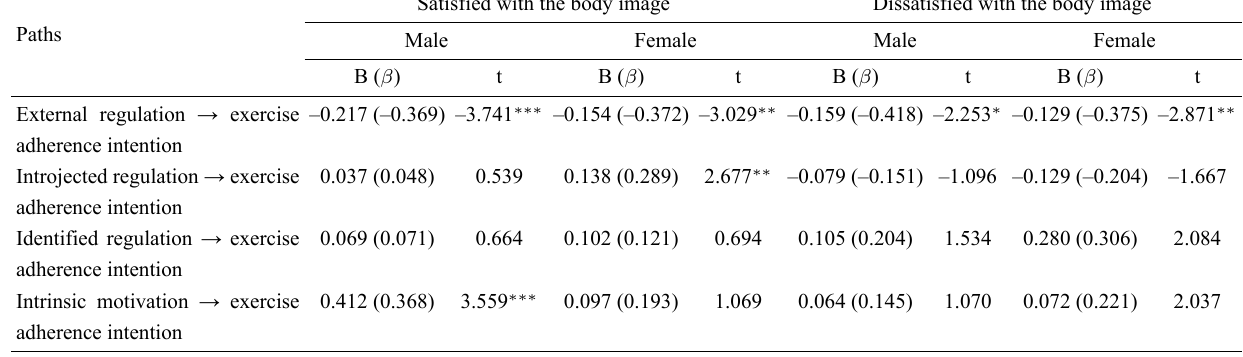
Table 6. Goodness of fit of the (baseline) model applying a constraint on measurement invariance and parameter estimates according to groups. Satisfied with the body image Dissatisfied with the body Paths